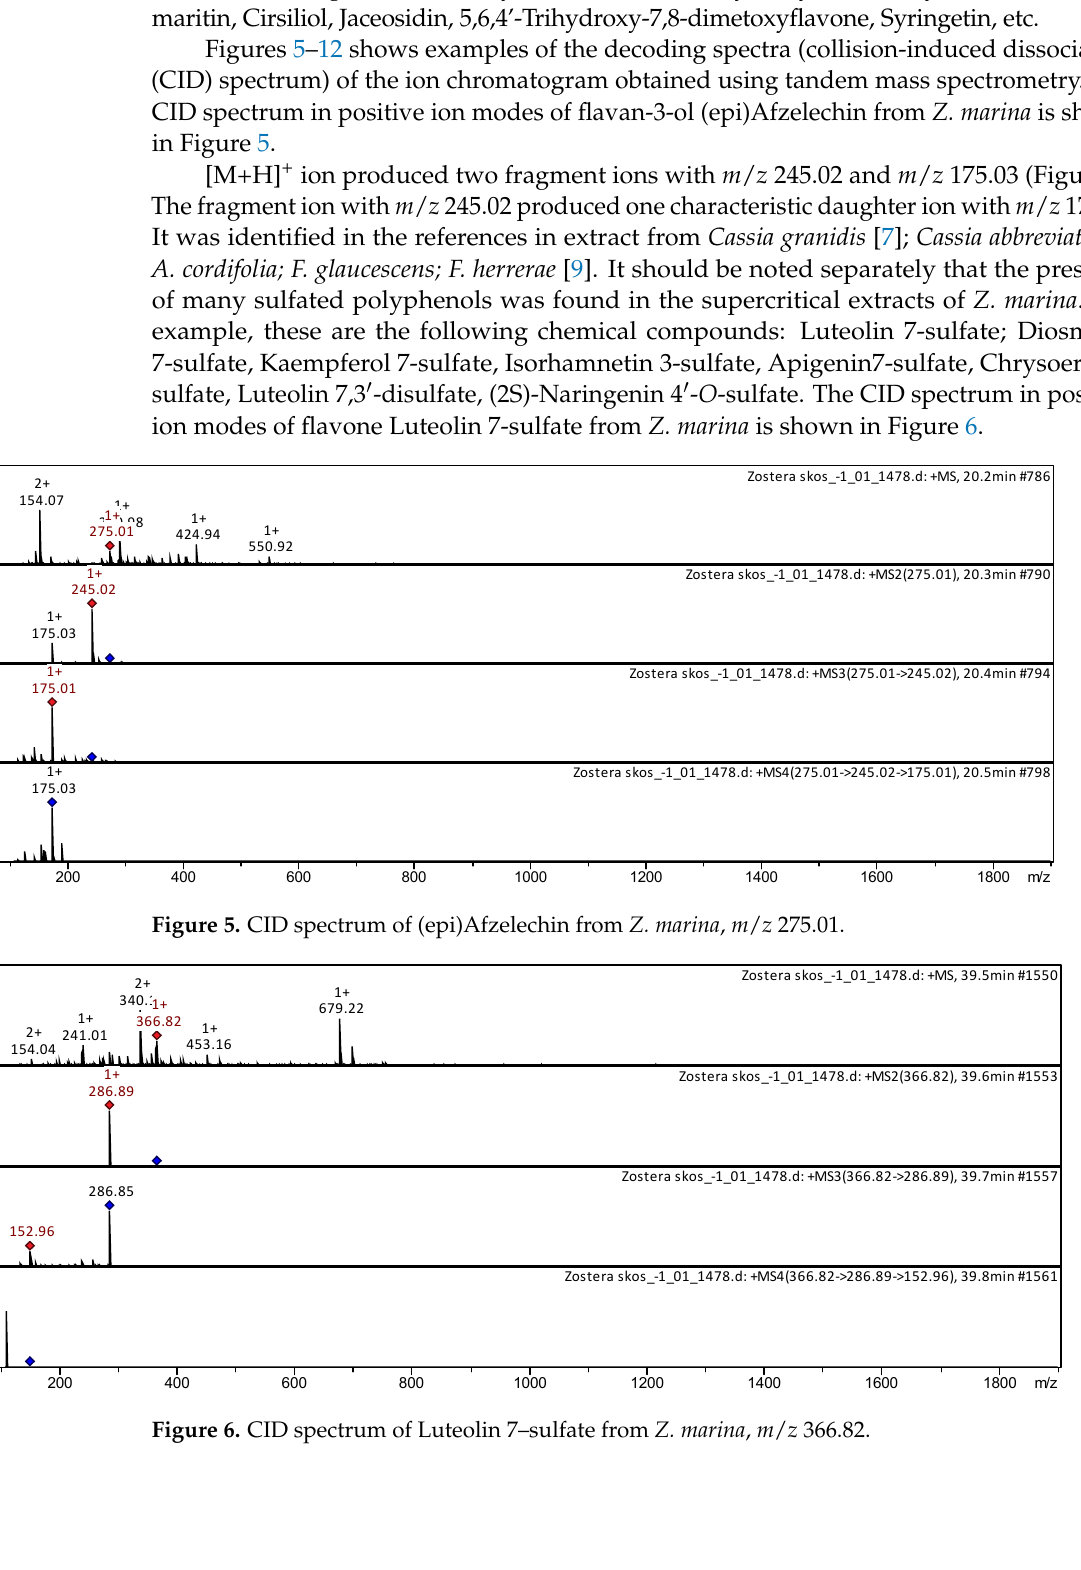
Figure 4. 3D–graph data of supercritical CO 2 -extraction. Total yield of biologically active sub- stances from extracts of Z. marina (Seagrass collected in water).